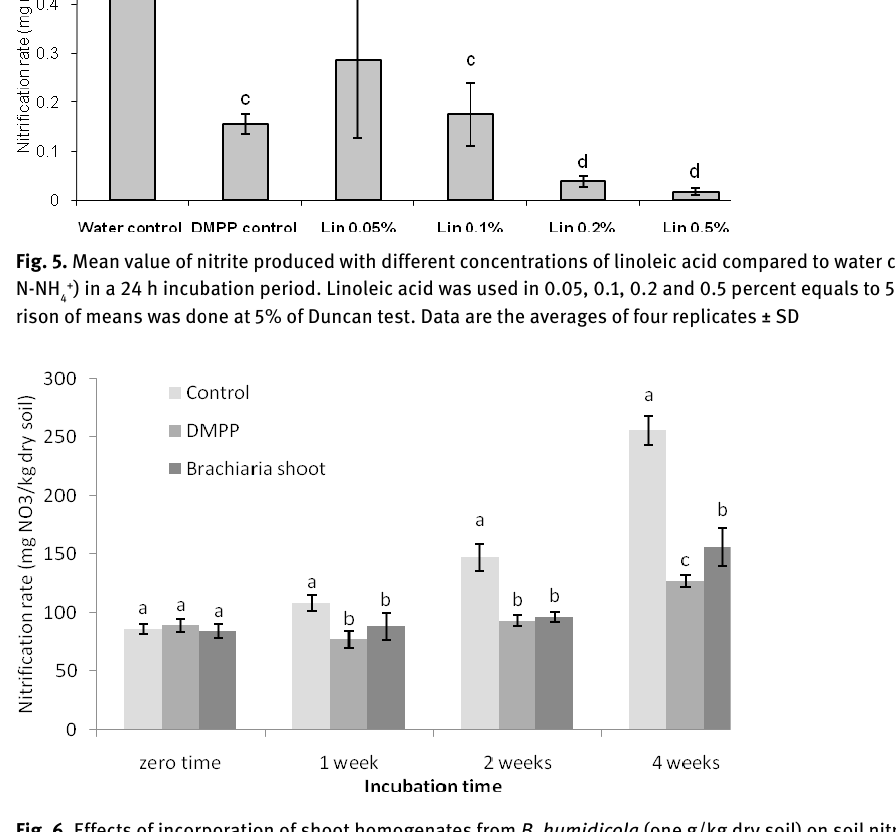
Fig. 6. Effects of incorporation of shoot homogenates from B. humidicola (one g/kg dry soil) on soil nitrification rates during four weeks incubation under laboratory room temperature of 20±2°C. Ammonium sulfate was added onto the soil based on 150 mg N-NH 4+ . In Brachiaria treatment ammonium sulfate was added onto the homogenated powder and then mixed uniformly with the soil. Small plastic pots contai- ning 200 g dry soil was used for this experiment. Comparison of means was done at 5% of Duncan